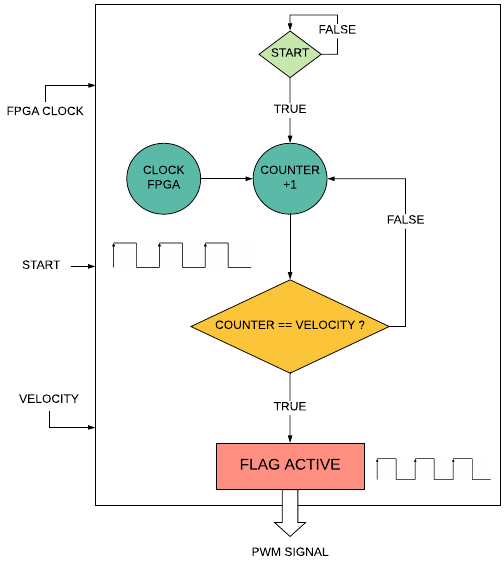
Figure 14. Flow diagram of PWM generator in